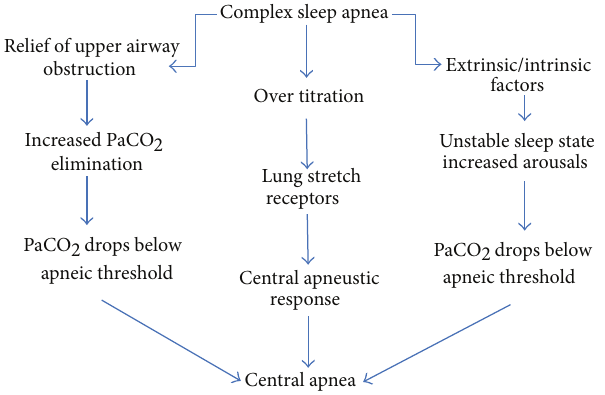
Figure 2: Schematic representation of pathogenesis of complex sleep apnea